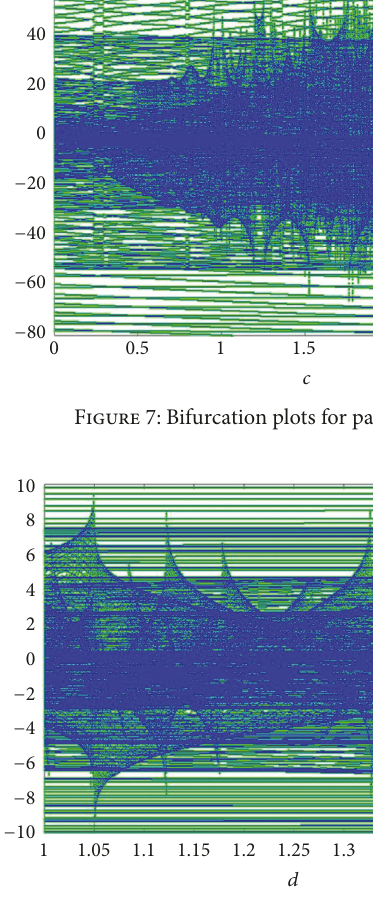
Figure 6: Bifurcation plots for parameter 𝑏 .